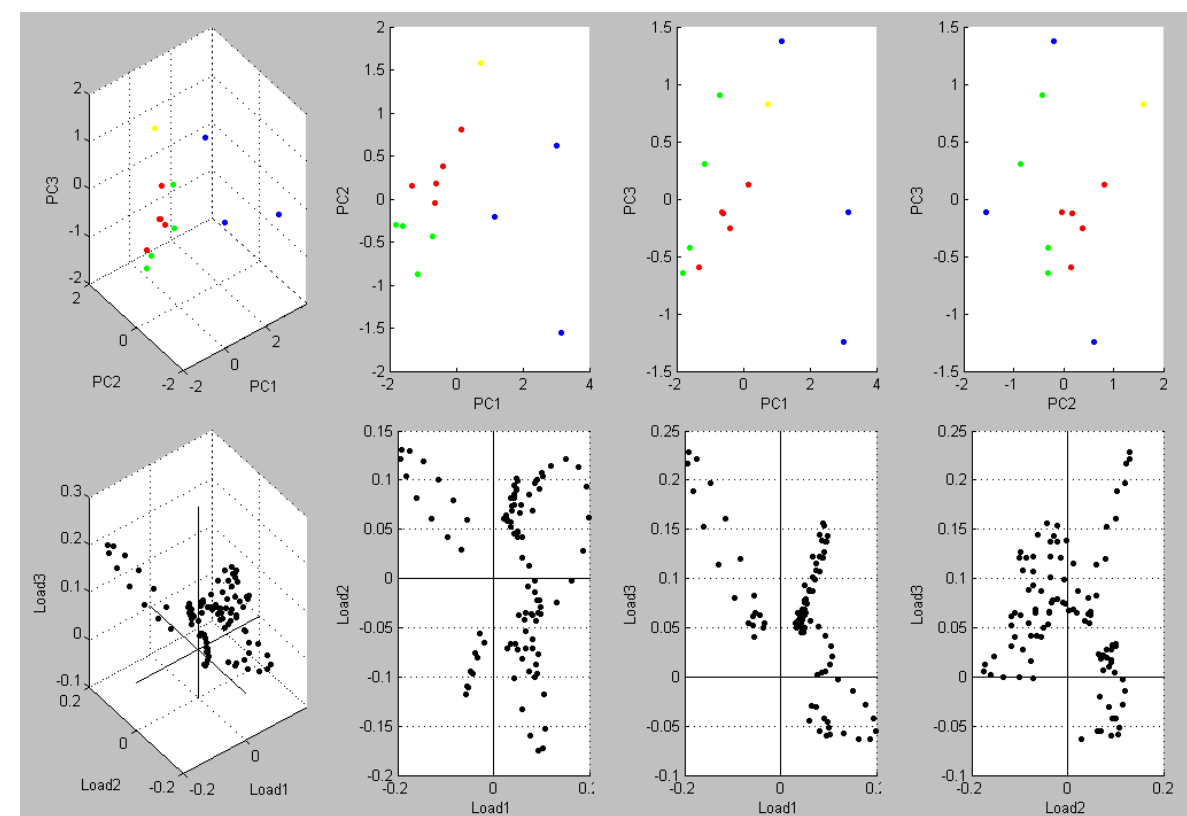
Figure 2. Three-dimensional principal component analysis of MALDI-TOF MS mass spectra of the tested E. coli isolates. The greatest potential for distinction was shown by PC1 and PC2 and a cluster of isolates was shown, whereas the non-related isolates are less similar.